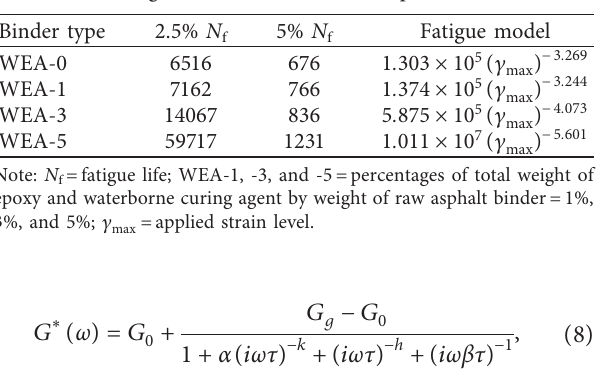
Figure 23: Creep and recovery behavior for binders at 60 ° C and 300Pa [17]. Table 3: Fatigue life based on linear amplitude tests